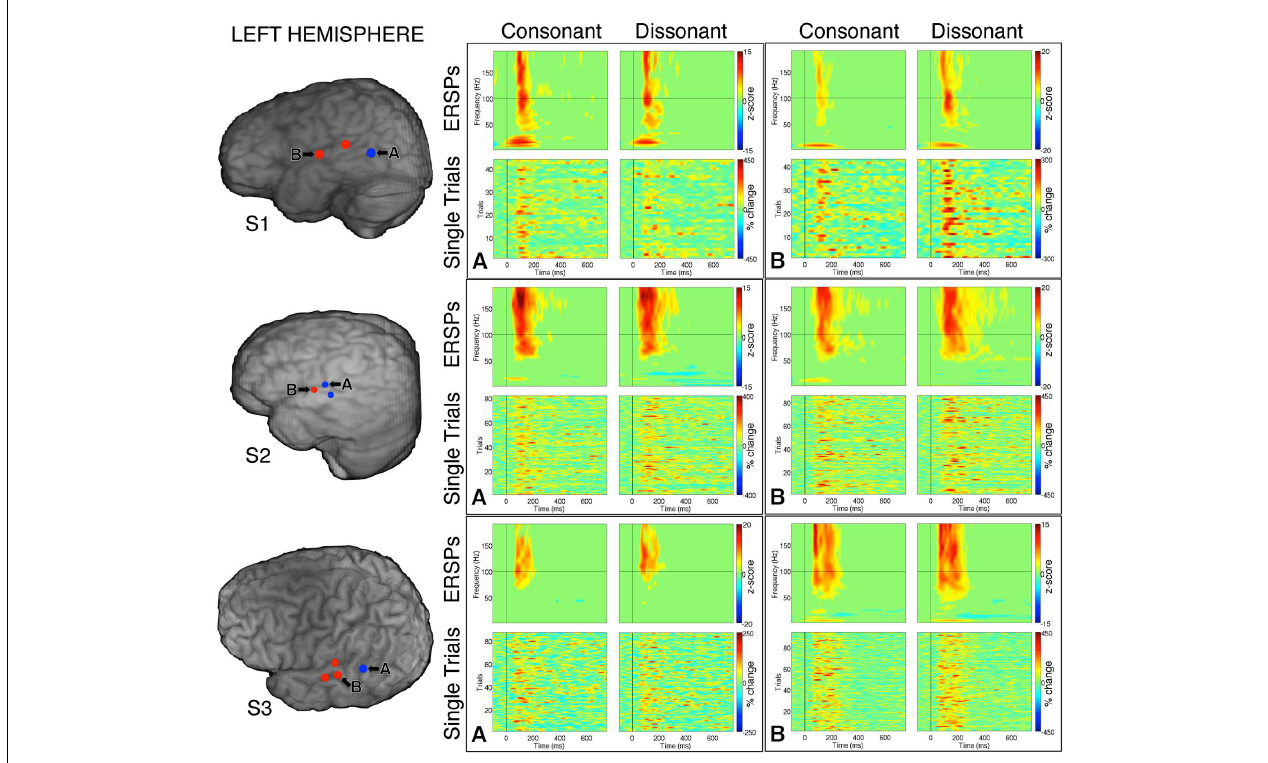
FIGURE 4 | Event-related spectral perturbations and Single Trial γ high responses to consonant vs. dissonant chords for one example electrode per response type (marked A and B respectively) for each subject with left hemisphere electrode coverage. All electrodes with significant γ high activity are included in individual subject brain images